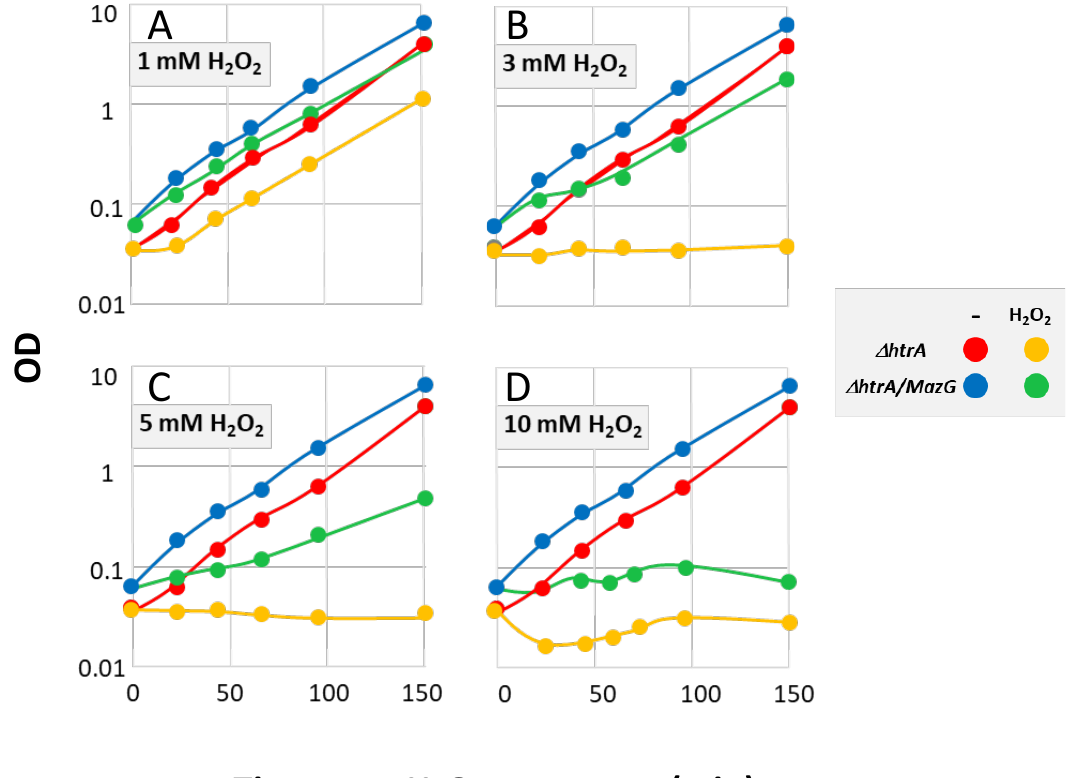
Figure 6. Growth of a MazG overexpressing ∆ htrA -strain under oxidative stress. B. anthracis cells of the ∆ htrA strain or ∆ htrA overexpressing MazG (referred as ∆ htrA / MazG) were grown in the absence (red circles: ∆ htrA ; blue circles: ∆ htrA / MazG) or presence (yellow circles: ∆ htrA ; green circles: ∆ htrA / MazG) of H 2 O 2 , as indicated in the legend on the right side. Panels ( A – D ) represent increasing concentrations of H 2 O 2 , as indicated above the curves. The growth curves in the absence of stress regimen are included in each panel for clarity. The curves describe the growth after initiation of the H 2 O 2 treatment (considered time 0) of a representative experiment. Two additional experiments were carried out yielding similar results.